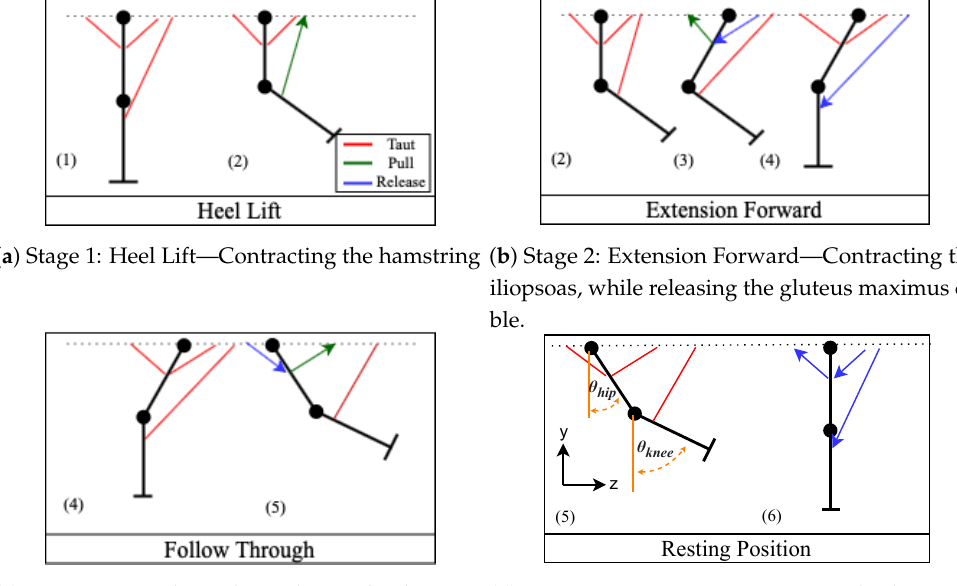
Figure 7. Outline of the active elements during the four stages of gait. Each pull (green) activates the cable-driven actuator to contract and shorten the muscle. The release of muscles (blue) reverses the direction of the actuator. In (Stage 4) the orange shows how the angles for the hip and knee were